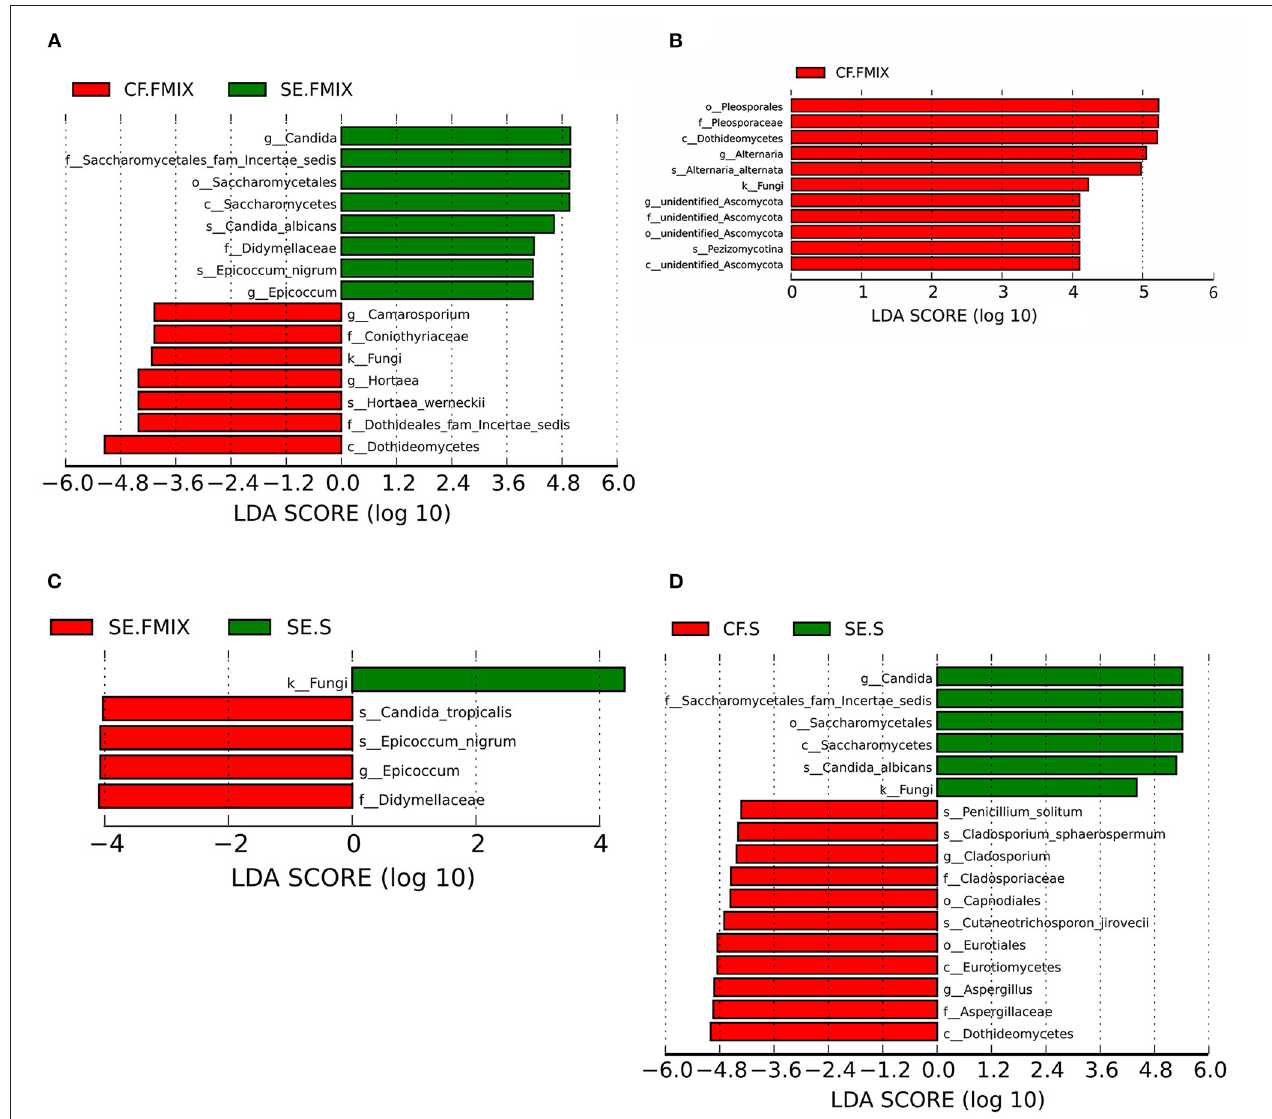
FIGURE 4 | Differential species among categories (Defined by LEfSe). The histograms show species with LDA scores greater than 3. (A) Differential species between CF.FMIX and SE.FMIX, (B) CF.FMIX and CF.S, (C) SE.FMIX and SE.S, and (D) CF.S and